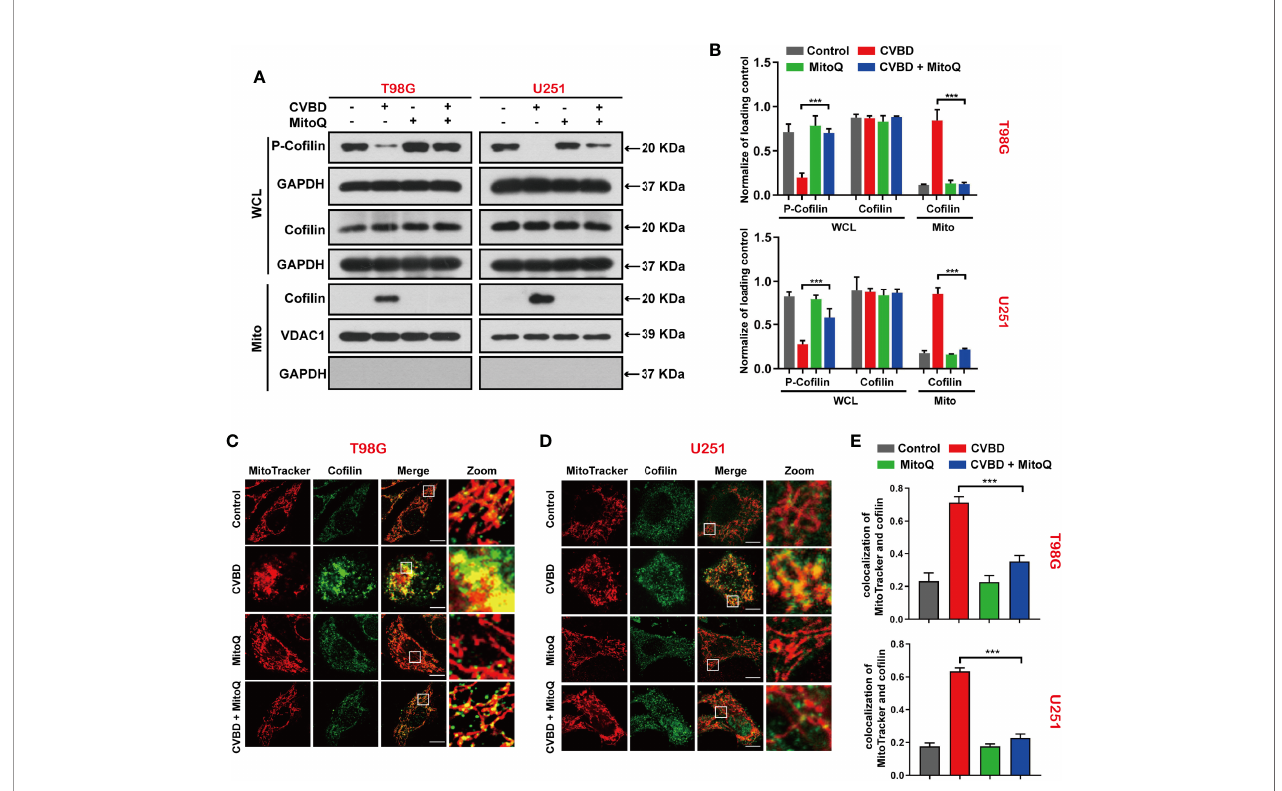
FIGURE 7 | Inhibited Mitochondrial superoxide production attenuates CVBD-induced mitochondrial translocation of co fi lin. (A, B) T98G and U251 cells were pre- treated with MitoQ (0.5 m M, 30 min) and post-treated with CVBD (120 m M) for 24 h. The expression level of p-co fi lin and co fi lin in the whole cell lysate (WCL), and co fi lin in the mitochondrial fractions, was determined by Western blotting analysis. GAPDH and VDAC1 were used as loading controls. GAPDH was also used as cytosolic marker (mean ± SD of three independent experiments, ***P < 0.001 compared with CVBD treatment alone). (C, D) T98G and U251 cells were treated as indicated in (A) , and the colocalization of MitoTracker (red) and co fi lin (green) was observed by confocal microscopy. Scale bars: 10 m M. (E) Quantitative analysis of colocalization of MitoTracker (red) and co fi lin (green). Colocalization correlation coef fi cients were represented as mean ± SD (***P < 0.001 compared with CVBD treatment